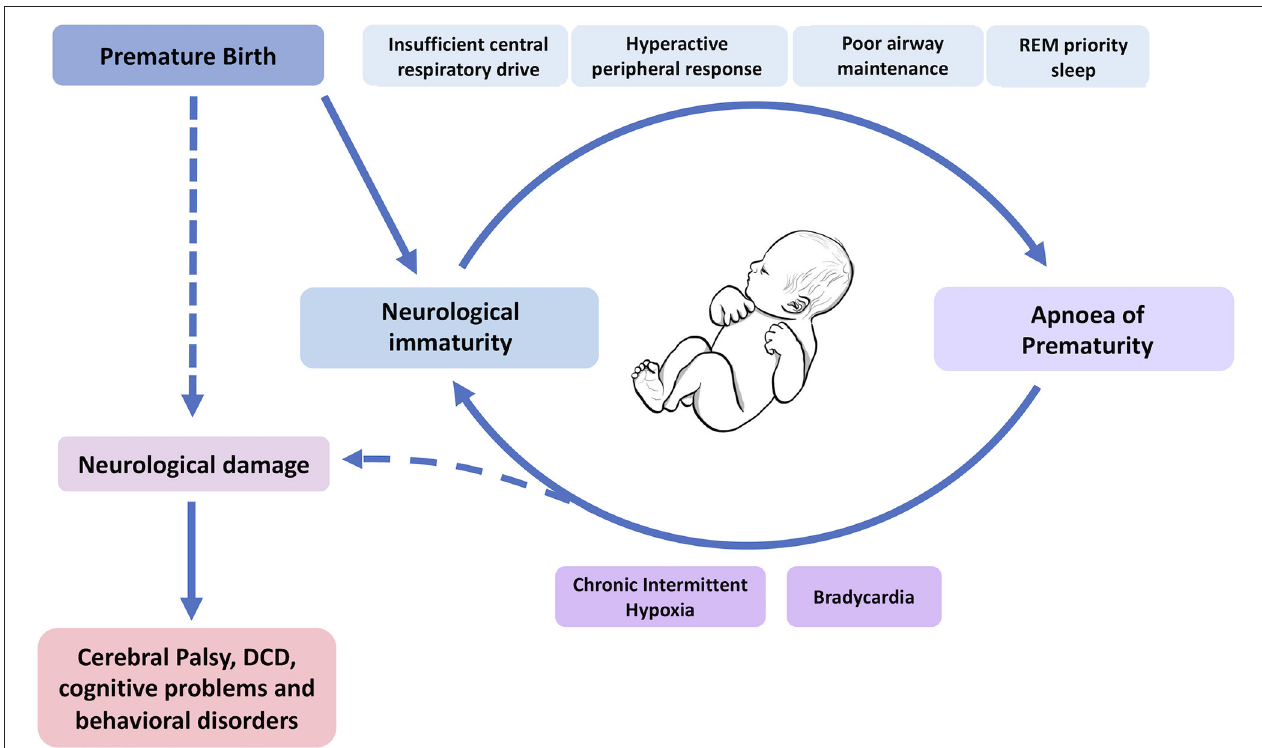
FIGURE 2 | Which comes first, the immaturity or the apnoea? A model of the interplay between the causes (top) and consequences (bottom) of apnoea of prematurity and respiratory immaturity in neonates, and how this might lead to neurodevelopmental impairment. DCD, developmental coordination disorder. Dashed lines indicate mixed causes between the sequelae of AOP and prematurity itself on neurological damage in these infants. This figure was created using BioRender (https://